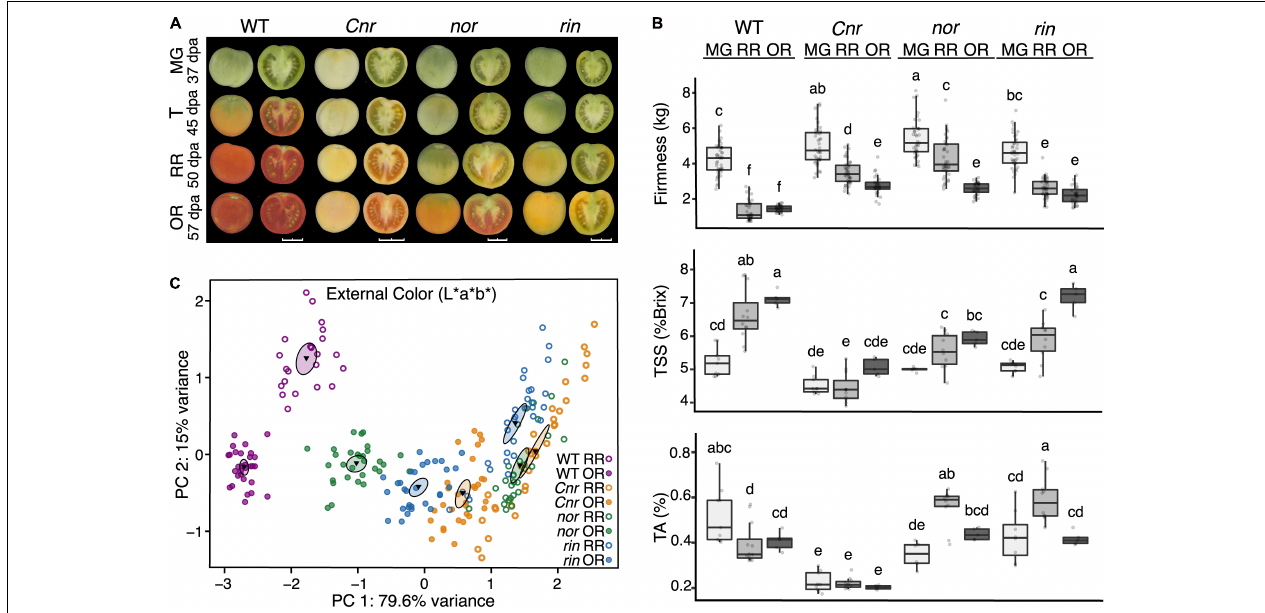
FIGURE 1 | Fruit traits of the tomato single ripening mutants. (A) Ripening progression of wild type (WT), c.v . ‘Ailsa Craig,’ compared to the isogenic mutants Cnr , nor , and rin across four developmental stages: mature green [MG, 37 days post anthesis (dpa)], turning (T, 45 dpa), red ripe (RR, 50 dpa), and overripe (OR, 57 dpa) shown at left whole and at right in longitudinal sections. Images were captured and processed with the VideometerLab instrument. Bars correspond to 2 cm. (B) Measurements of fruit firmness ( n = 28–44), total soluble solids (TSS) ( n = 5–12), and titratable acidity (TA) ( n = 5–12) for each MG, RR, and OR stages are presented. Error bars represent standard error between biological replicates of each sample. Letters indicate significant differences among genotypes and stages calculated by ANOVA and Tukey HSD ( P ≤ 0.05). (C) Principal component analysis of external color measured on the L*a*b* color scale of each genotype at the RR ( n = 22–34) and OR stage ( n = 28–40). The center of gravity is represented by a triangle with surrounding ellipses indicating 95% confidence